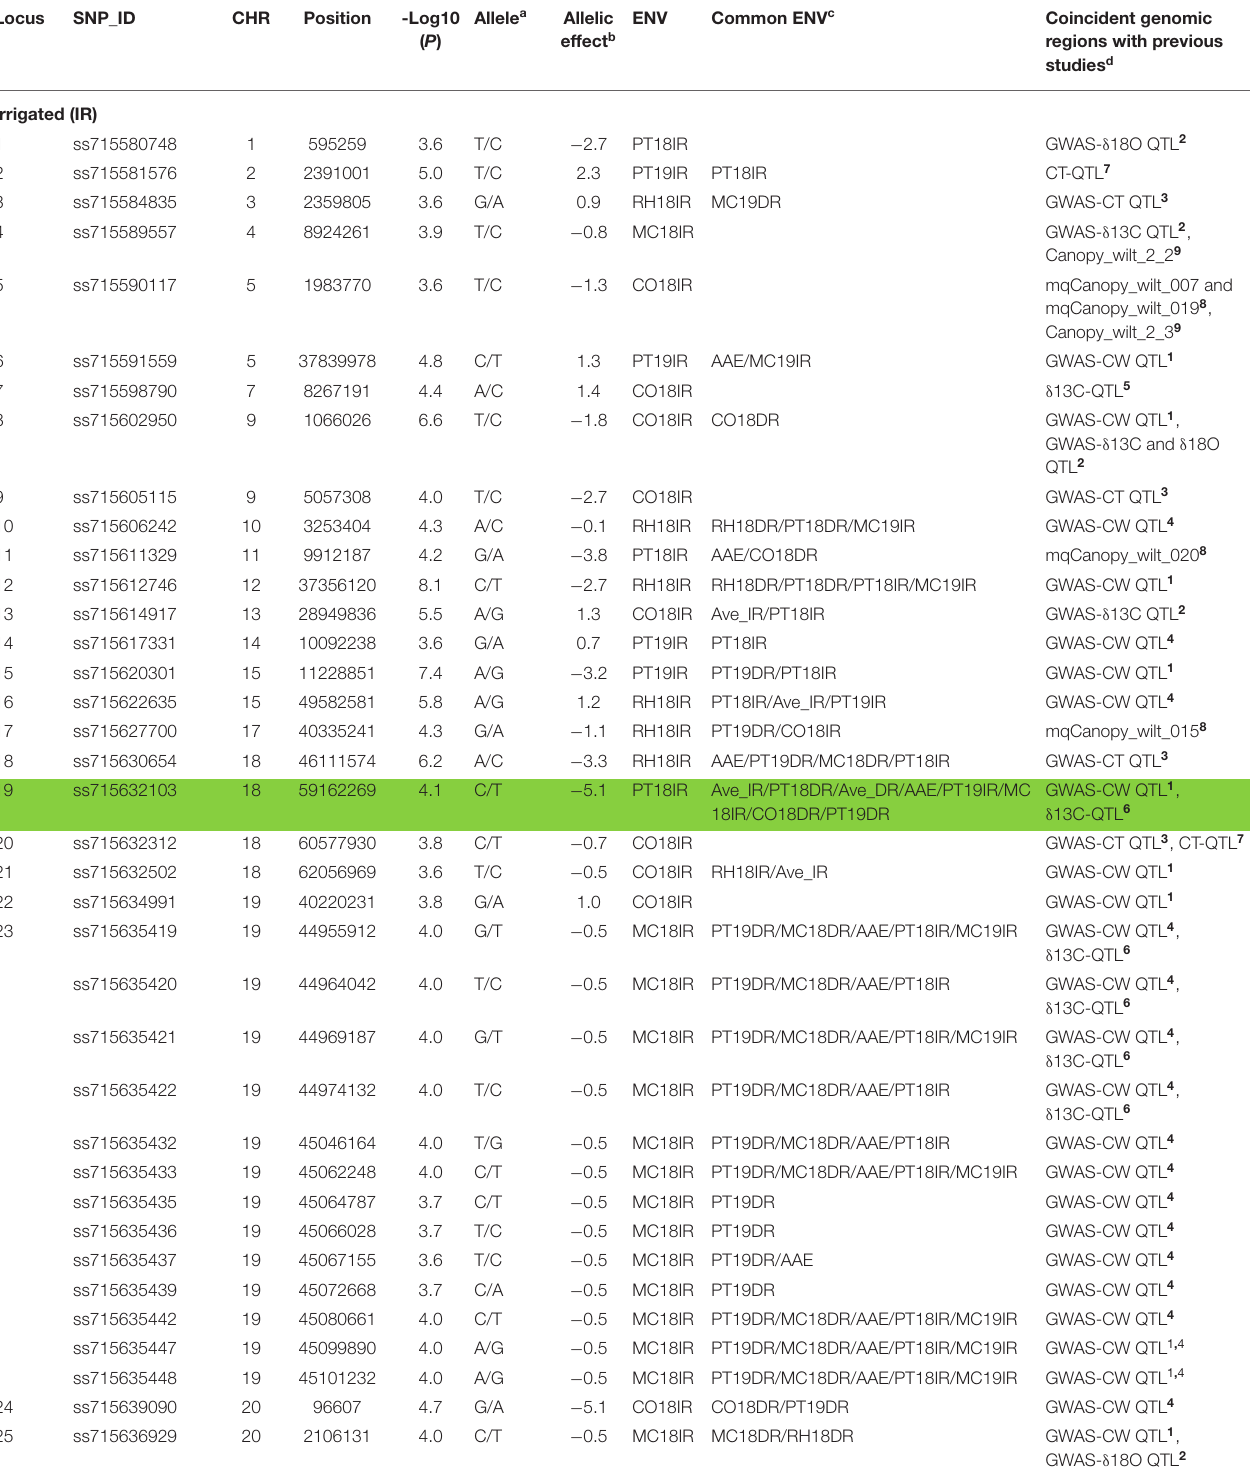
TABLE 3 | Significant coincident single-nucleotide polymorphisms (SNPs) with previous studies associated with CW with the 12 environments, Columbia (CO18), Maricopa (MC18 and 19), Pine Tree (PT18 and 19), and Rohwer (RH18) under IR and DR treatments, and for averaged across site-years for irrigated (Ave_IR) and drought (Ave_DR) treatments, and averaged across all environments (AAE) at the significance threshold of –Log10 ( P ) ≥ 3.5; P ≤ 0.0003. Locus SNP_ID CHR Position -Log10 Allele a Allelic ENV Common ENV c Coincident genomic ( P ) effect b regions with previous studies